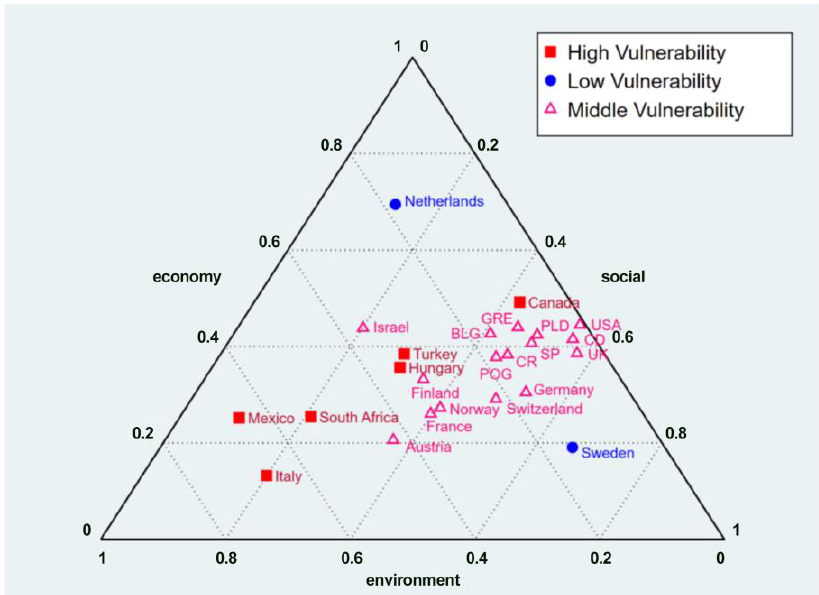
Figure 3. Structural analysis of low-carbon energy vulnerability in OECD countries in 2018. Note: BLG, CO, CR, GRE, PLD, POG, and SP are the abbreviations of Belgium, Columbia, Czech Republic, Germany, Poland, Portugal, and Spain, respectively.